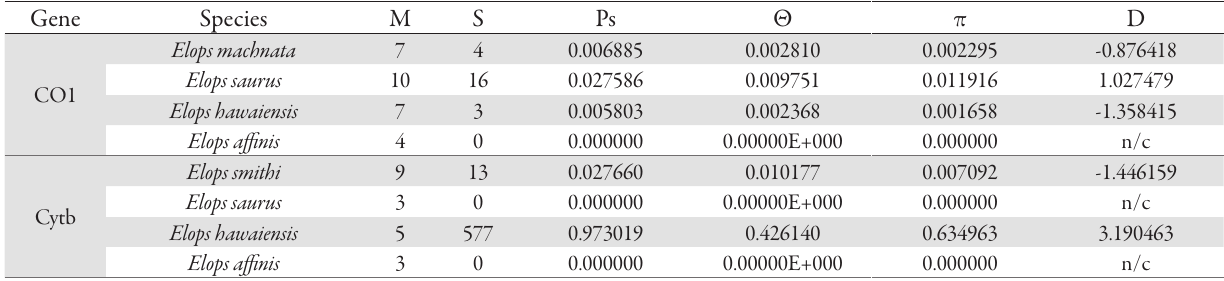
Fig. 6. Neighbour joining tree of Elops species based on 12S rRNA gene sequences Tab. 5. Tajima’s Neutrality Test for CO1 and Cytb genes in Elops